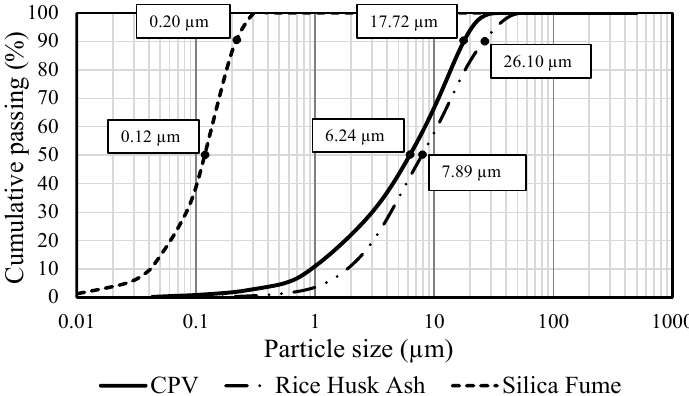
Figure 2. Particle size distribution of